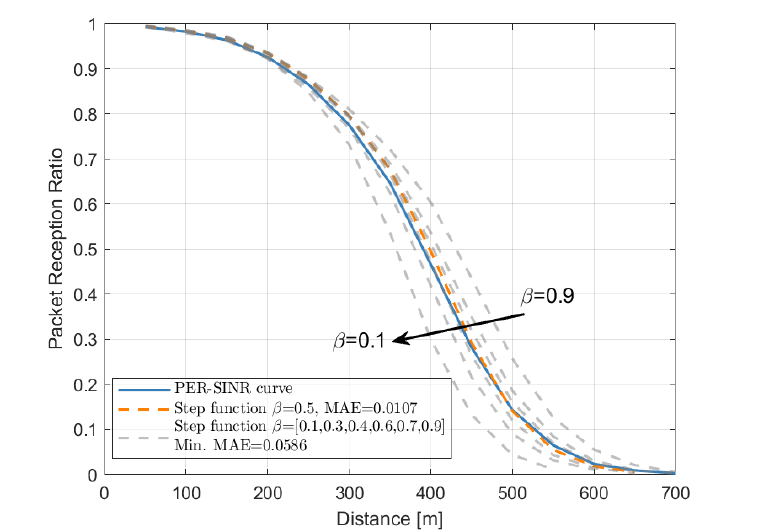
Figure 3. PRR vs. distance assuming the PER vs. SINR curve (solid curve) or the step function with different values of β (dashed curves). LTE-V2X MCS 7, 350 bytes, 100 vehicles/km. The orange dashed curve corresponds to β =